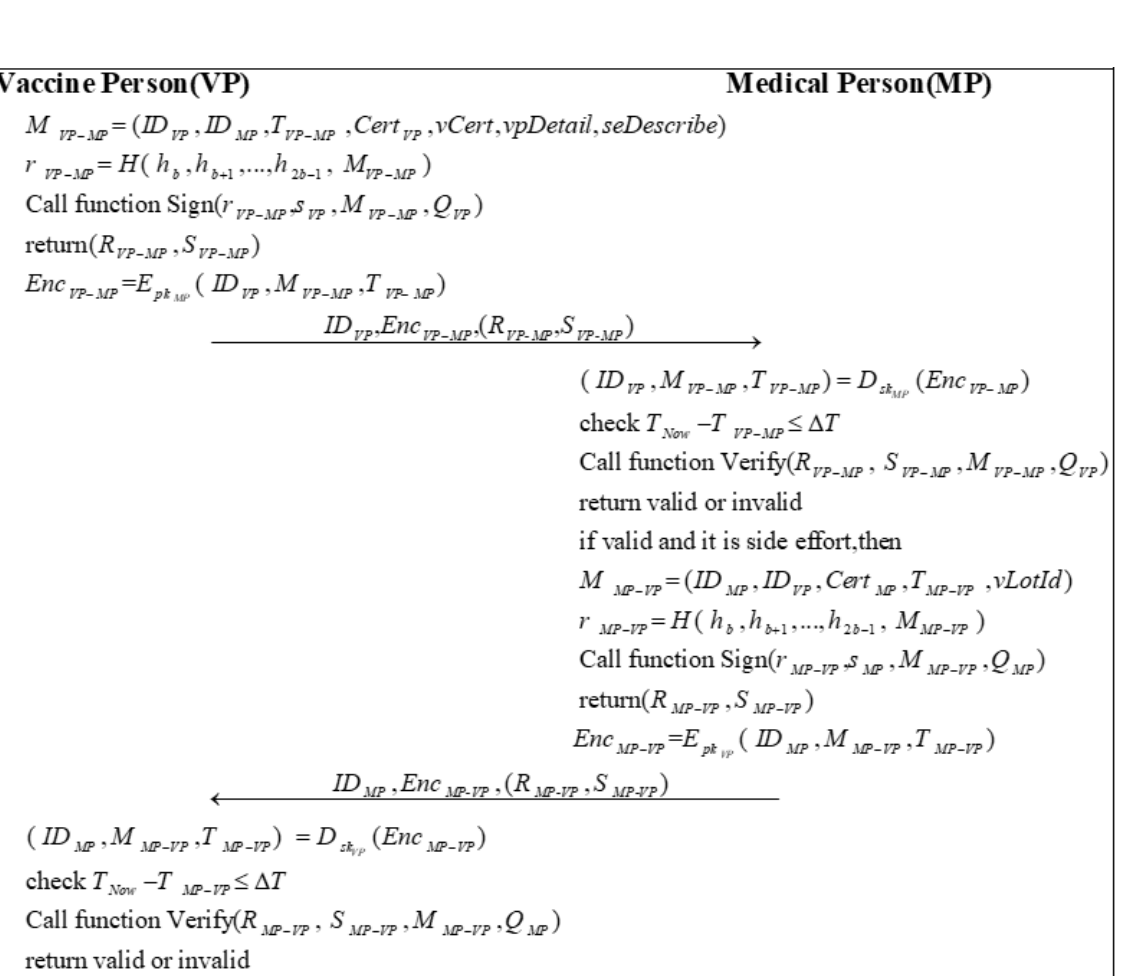
Figure 10. The process of the side effects submitted.